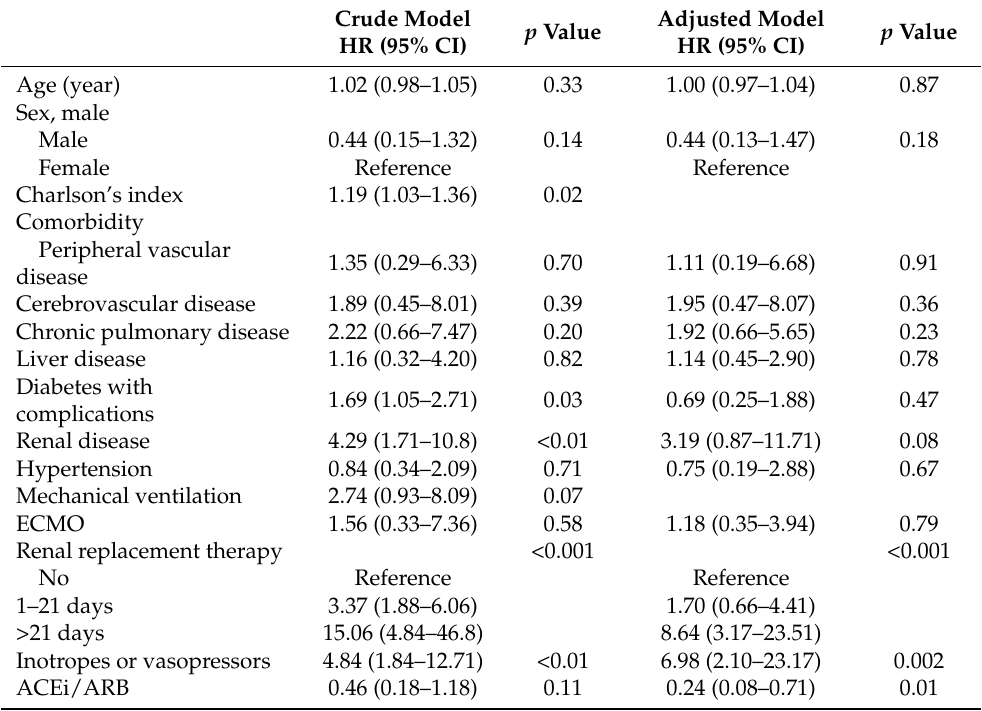
Figure 1. Incidence of end-stage kidney disease (ESKD) after heart transplantation. The median followup duration was 2.8 years (interquartile range: 1.2–4.8), and 12 patients (1.8%) developed ESKD. In the Kaplan-Meier analysis, the incidence rate of ESKD was 5.7 per 1000 person-years. Table 2. Predictors of end-stage kidney disease (ESKD) after heart transplantation ( n = 654).